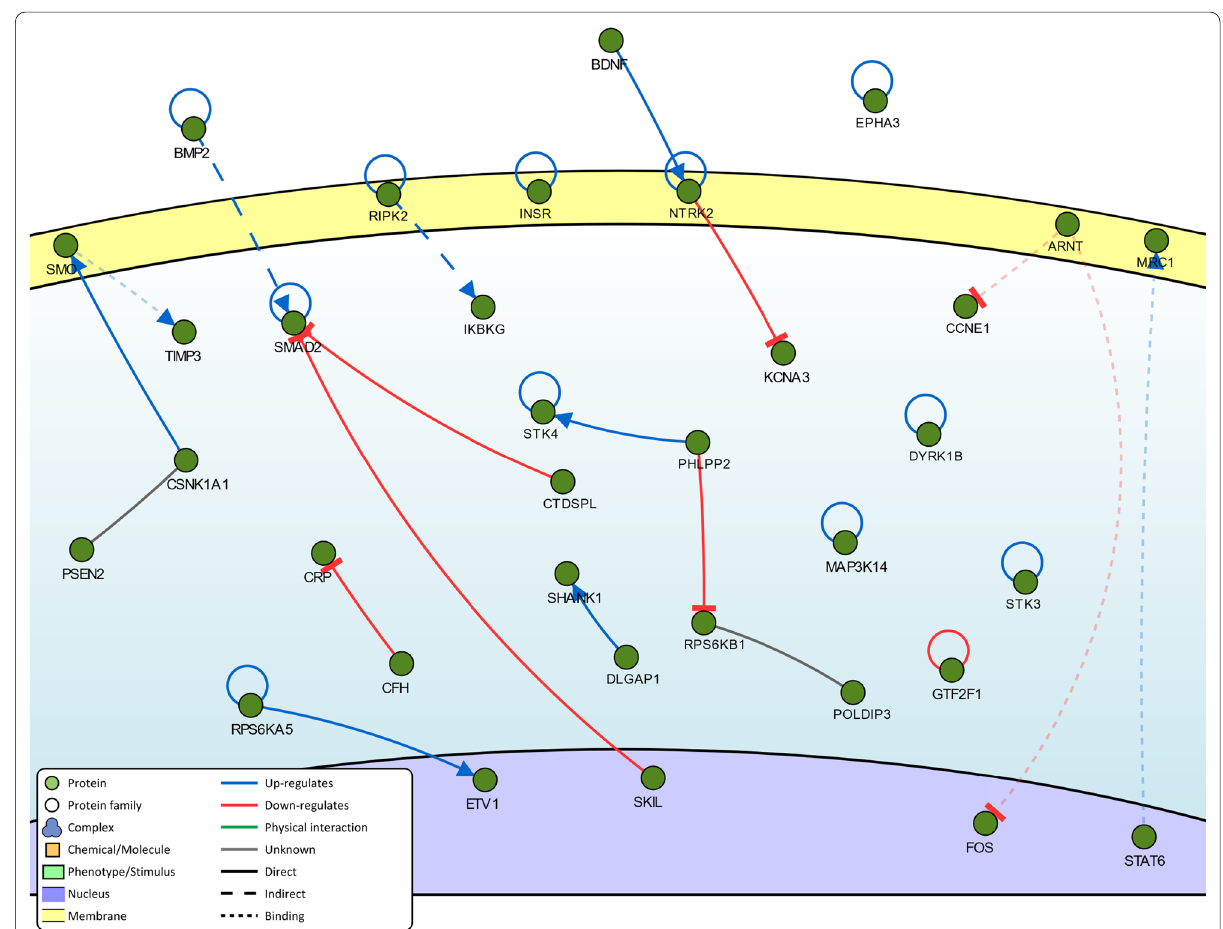
Fig. 9 Pathway signaling network generated from the most significantly differentially expressed genes. Different shapes represent molecular class, while red and blue indicate downregulation and upregulation,